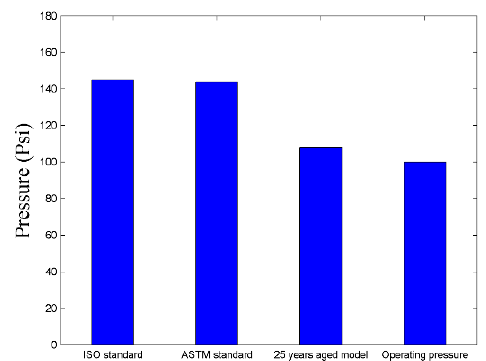
Figure 7. Operating pressure comparison of PE 100 enclosure’s new and aged models with required operating pressure of FGIL.